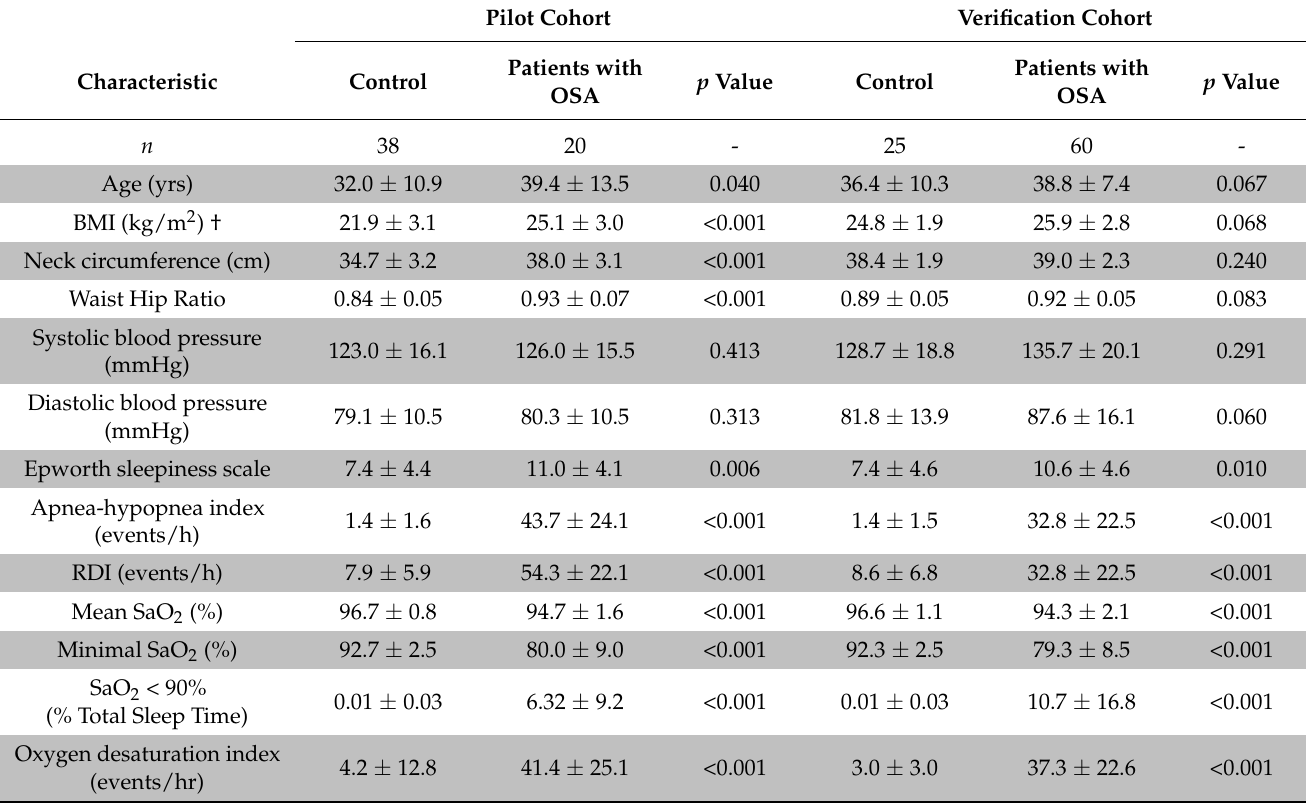
Table 1. Baseline characteristics of patients with the obstructive sleep apnea syndrome and controls